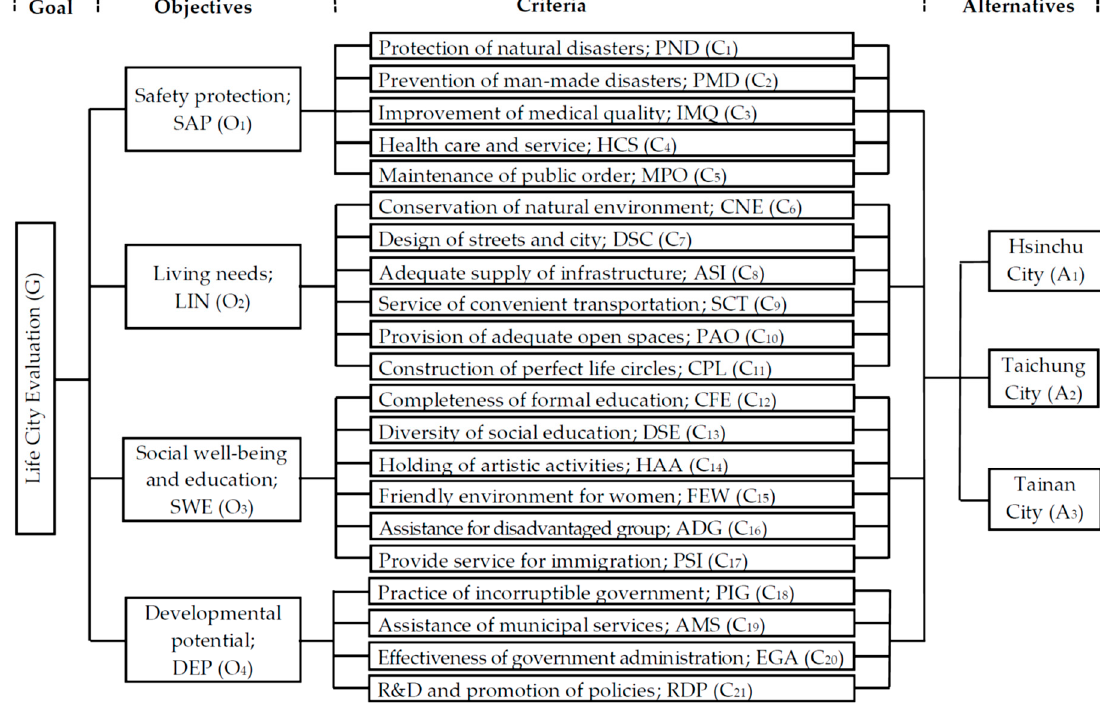
Figure 4. The overall Life–City evaluation framework.